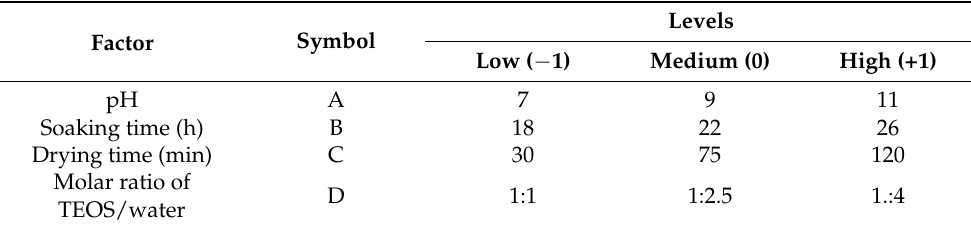
Table 1. Factors and ranges for in situ silica sol-gel silica synthesis on oil palm fiber.